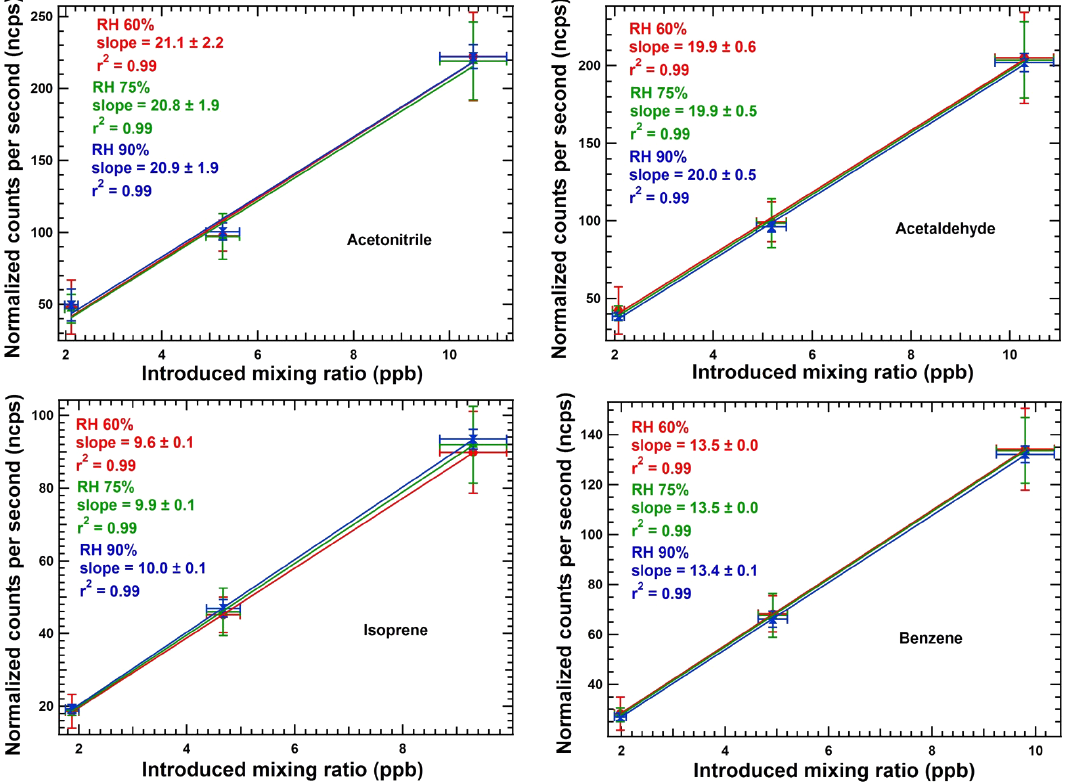
Figure 3. Compound specific normalised sensitivities at different relative humidities (RH 60, 75 and 90%) for acetonitrile, acetaldehyde, isoprene and benzene during the calibration experiment performed on 10 January 2013. Horizontal bars reflect the error due to the MFC flows and the accuracy of the VOC gas standard whereas vertical bars reflect the precision error (2 σ ) of the measurements.